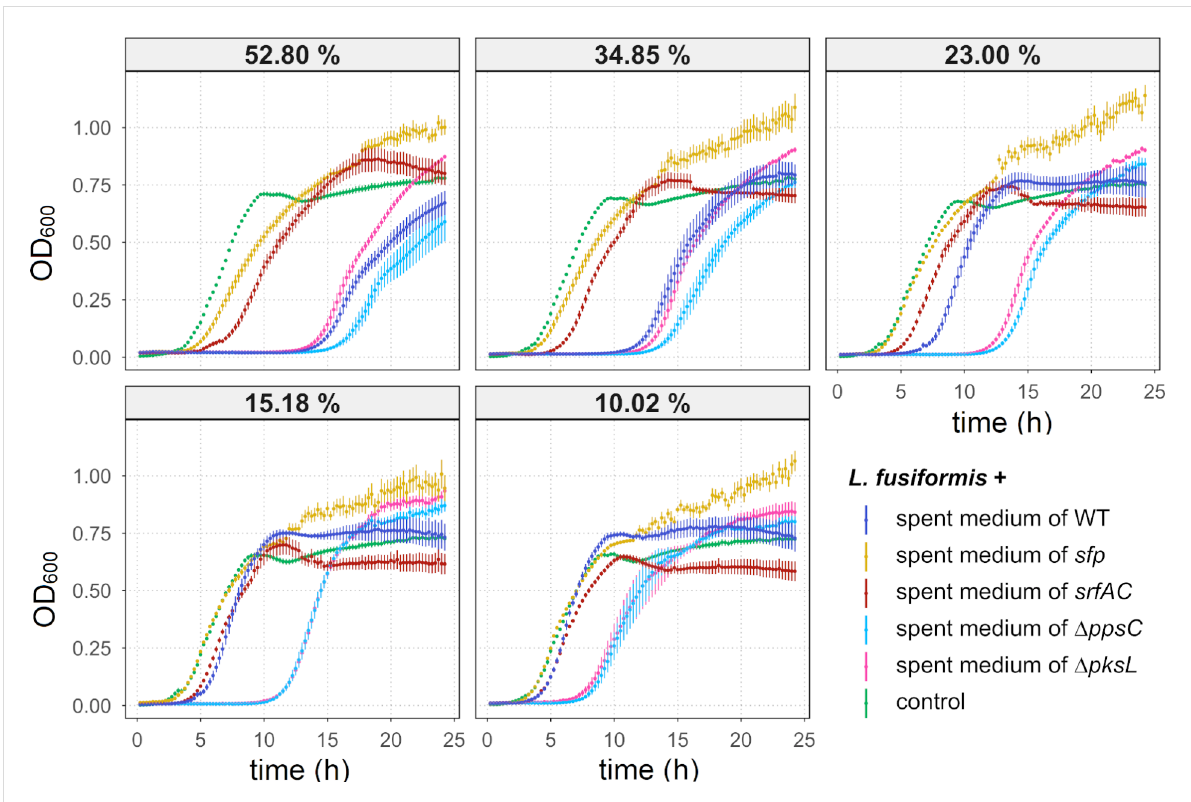
Figure 7: Growth curves of L. fusiformis M5 exposed to spent media from 48 h B. subtilis cultures and without treatment (“control”). The spent medi- um concentration of 10.02% to 52.80%, acquired with a serial dilution, indicates the proportion of spent medium from the total volume. The error bars represent the standard error. N ≥ 6. OD 600 = optical density at 600